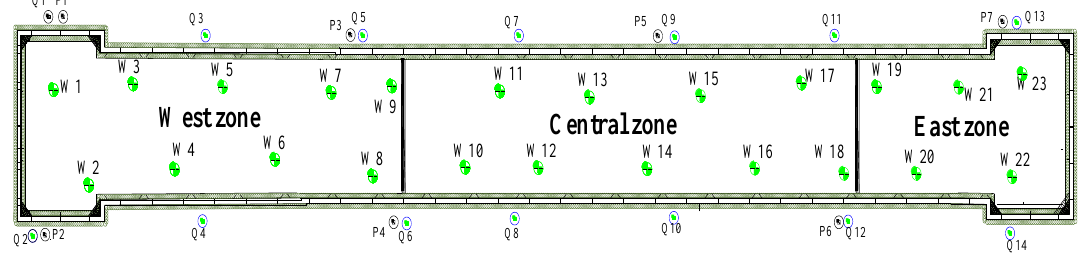
Figure 10. The location of the pumping and observation wells. Table 4. Procedure of pumping